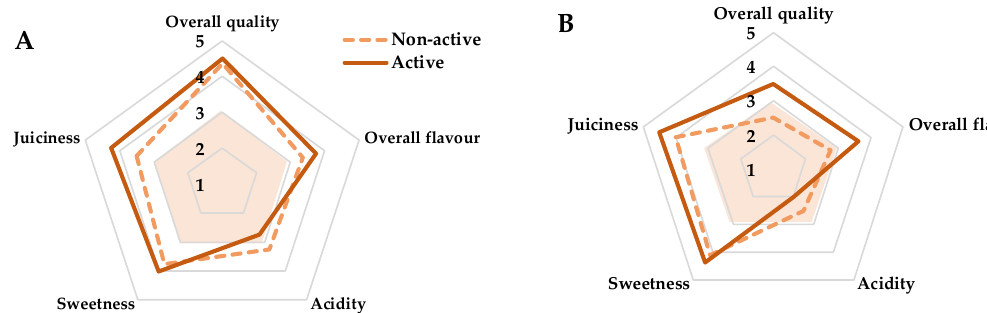
Figure 5. Sensory scores of mandarins packaged within active or non-active package after 14 days ( A ) and 21 days ( B ) of storage at 8 ◦ C. The coloured orange area defines the limit of acceptability (scores below 3 are considered below the limit of acceptability).